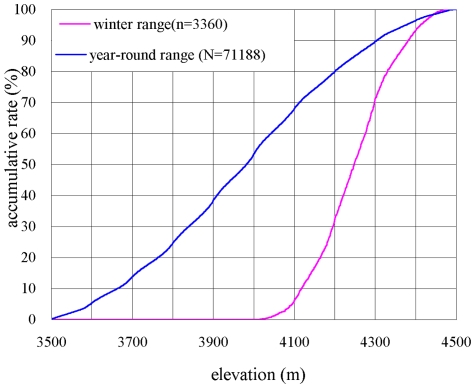
The cumulative percentage of area for winter home range and year-round home range along with elevation (3501–4500 m).